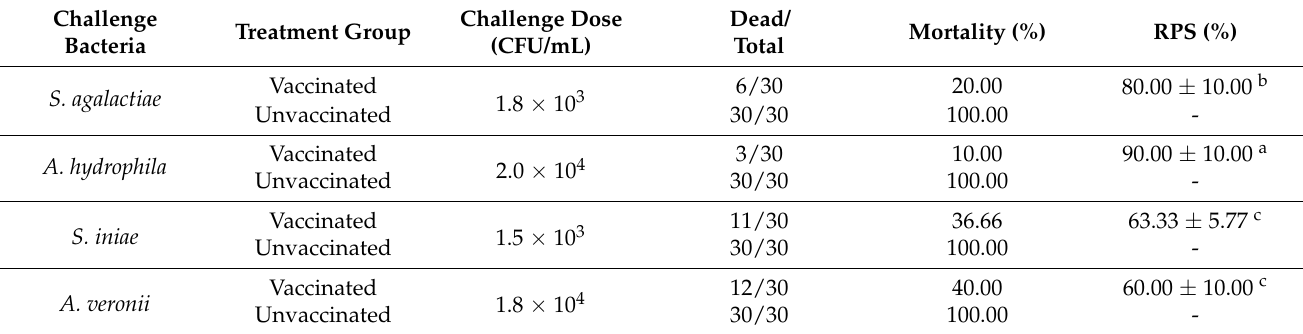
Table 3. Mortalities and relative percentage survival (RPS) of red hybrid tilapia 14 days post- challenged with Streptococcus spp. or Aeromonas spp. Values are the mean ± standard deviation in triplicate samples. Different superscript letters (a–c) within the column indicate a significant difference at p ≤